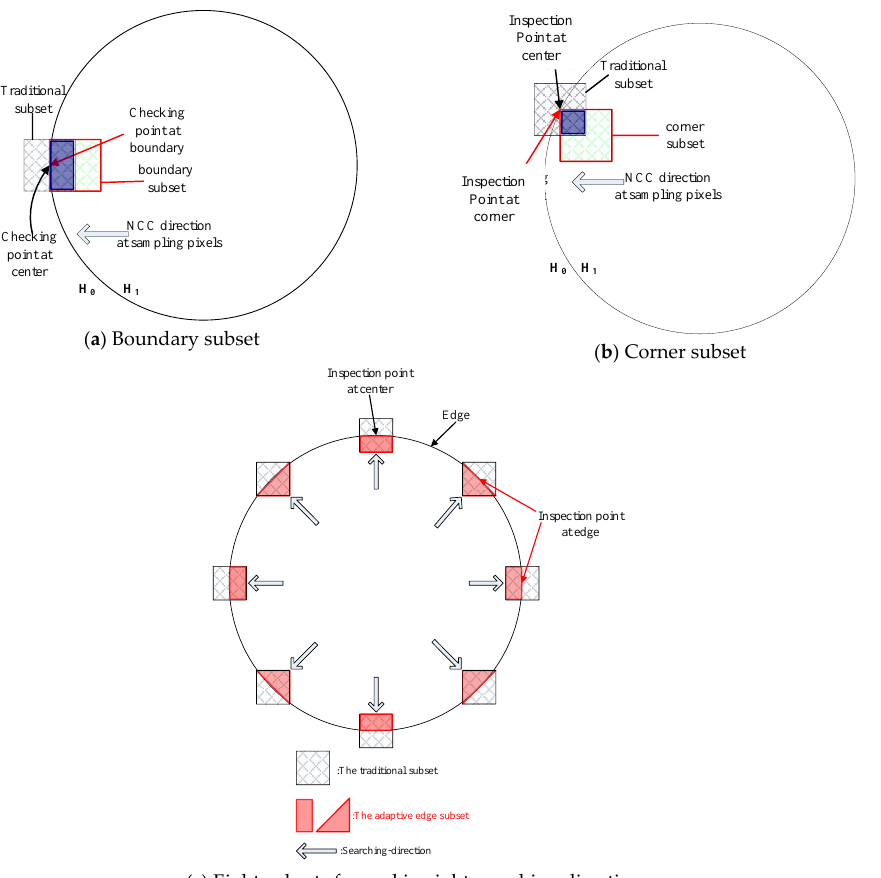
Figure 10. Proposed speckle subsets for contour edge detection.